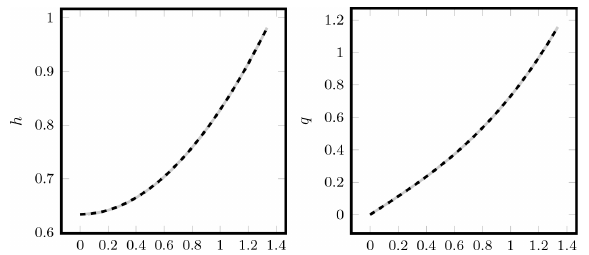
Figure 4. Similarity results for the finest resolution mesh (solid lines) compared against the analytical results (dashed lines) at t = 10 .